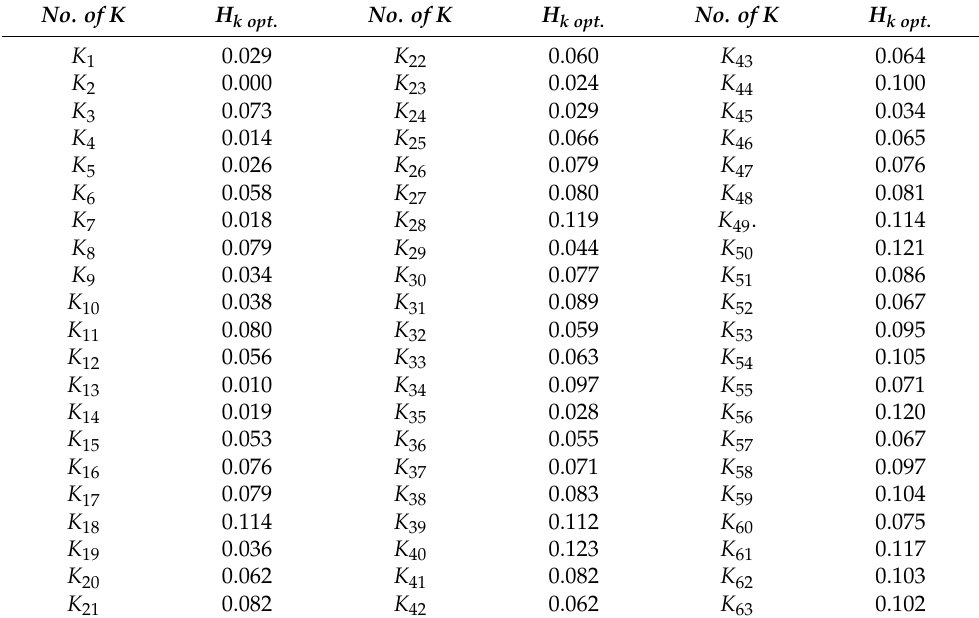
Table 6. The list of H k opt . values for each combination. No. of K H k opt